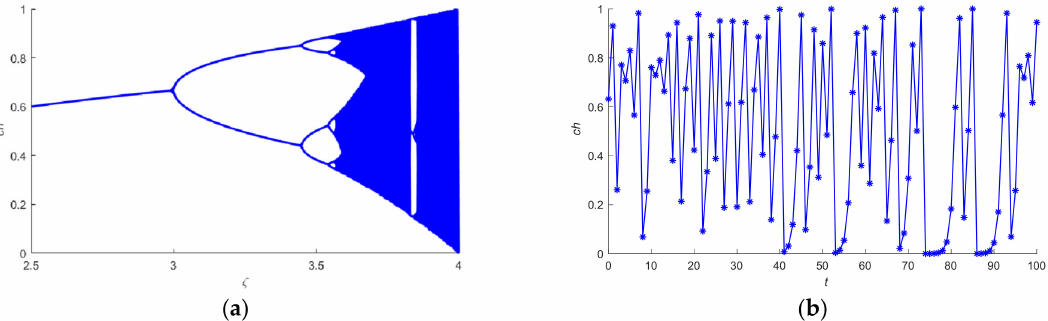
Figure 1. ( a ) Bifurcation diagram for the logistic map; ( b ) a logistic chaotic map sequence after 100